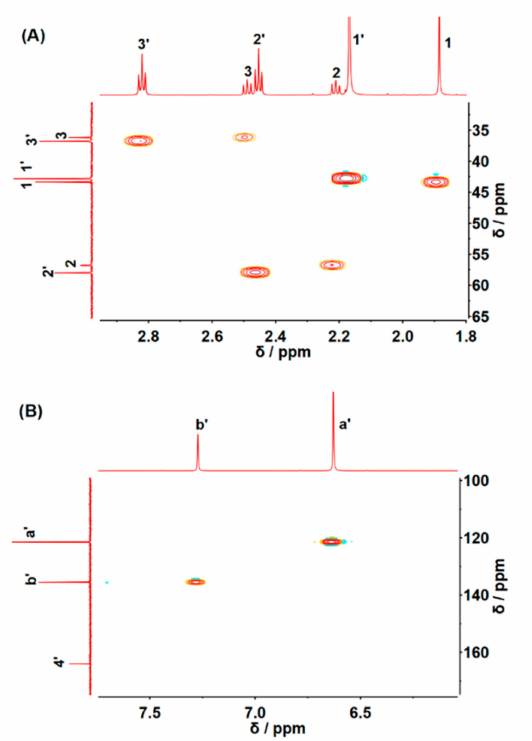
Figure 2. The 1 H- 13 C HSQC spectra of [DMEDAH] [Im] after CO 2 capture ( A , B ); D 2 O was used as the internal solvent to record the